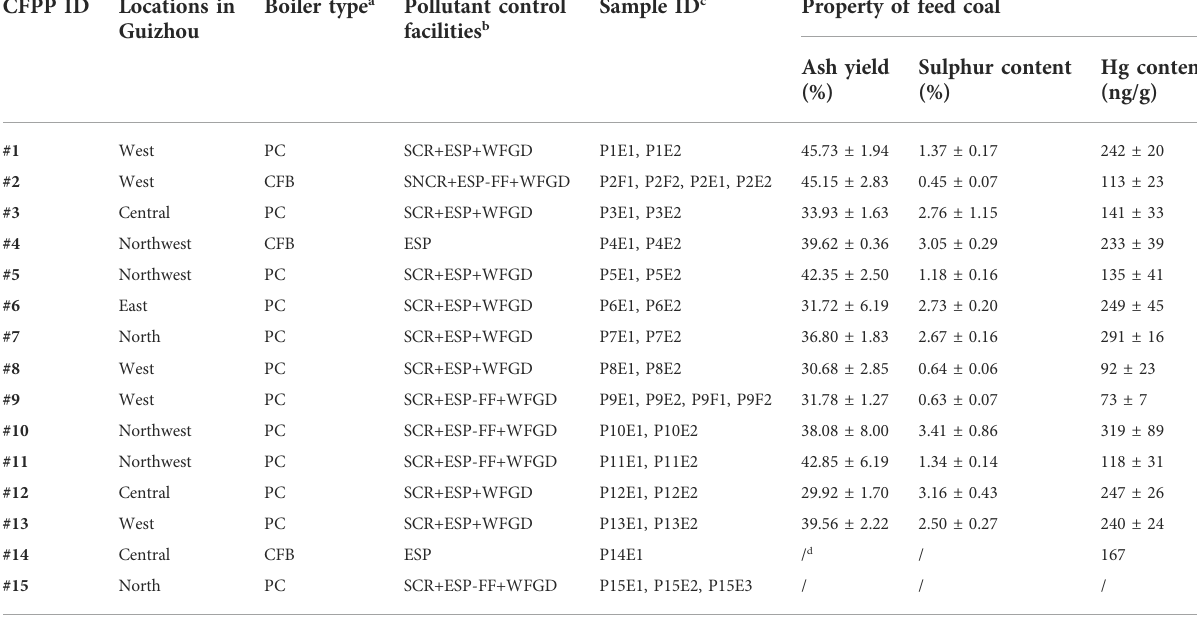
TABLE 1 Detailed information about the CFPPs in Guizhou Province, China and the sample ID for coal fl y ash samples.